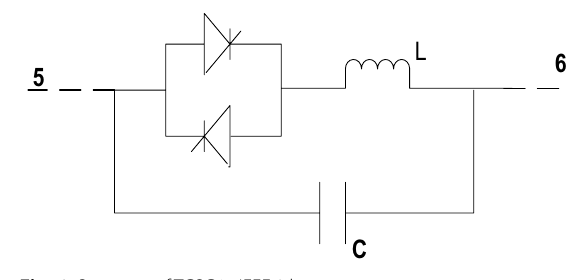
Fig. 6 Structure of TCSC in IEEE 9 bus system